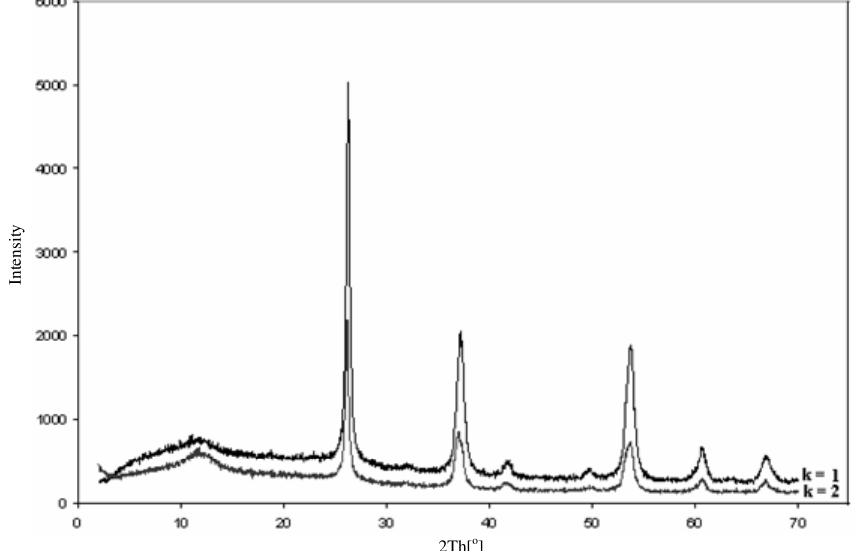
Figure 1. XRD patterns of the products formed with different value of k